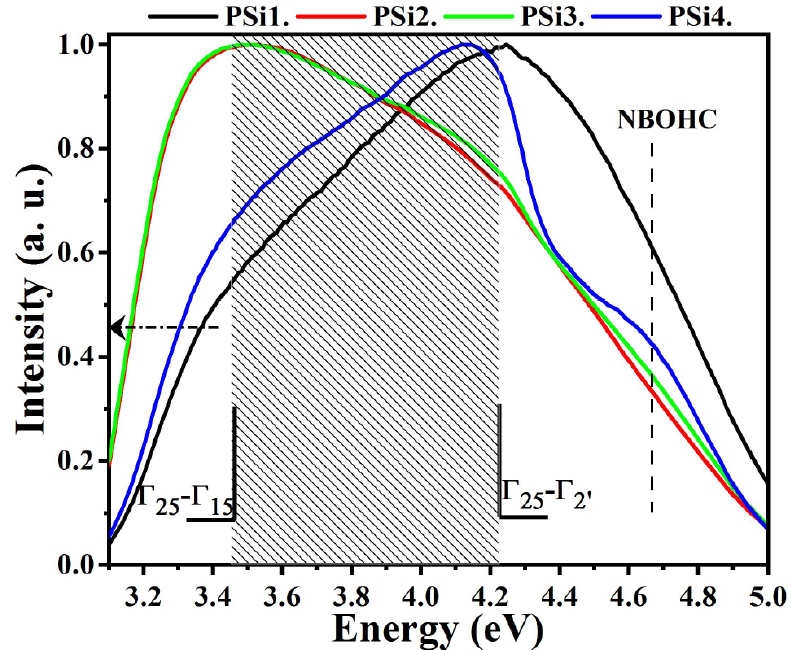
Figure 2. PLE spectra of PSi films measured at their maximum PL peak energy.